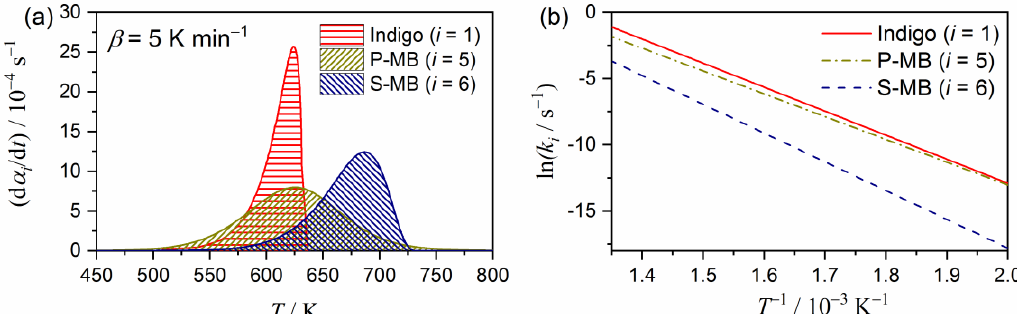
Figure 13. Comparison of the kinetic characteristics for the thermally induced sublimation/decomposition of indigo as crystalline particles, incorporated in P-MB ( i = 5), and in S-MB ( i = 6): ( a ) Kinetic curves and ( b ) Arrhenius plots.